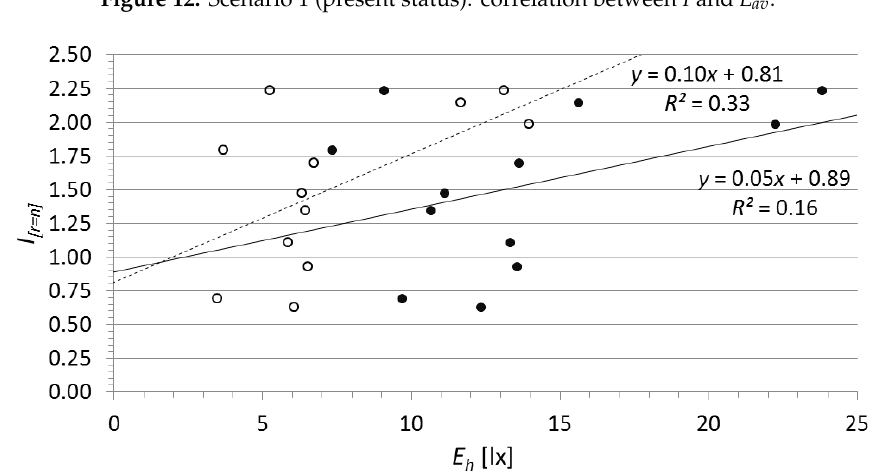
Figure 13. Scenario 1 (present status): correlations between I and E h,av (black circles and a continuous line for the regression) and between I and E h,min (white circles and a dotted line for the regression) on the sidewalks on the same side of luminaires.